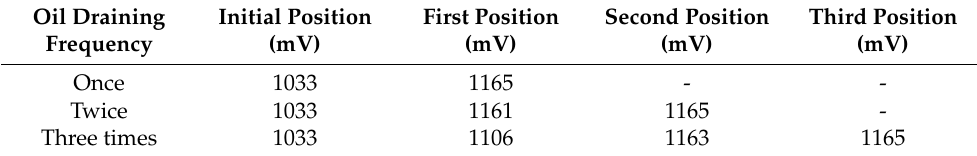
Table 3. The value of the cable displacement sensor corresponding to the depth interval.